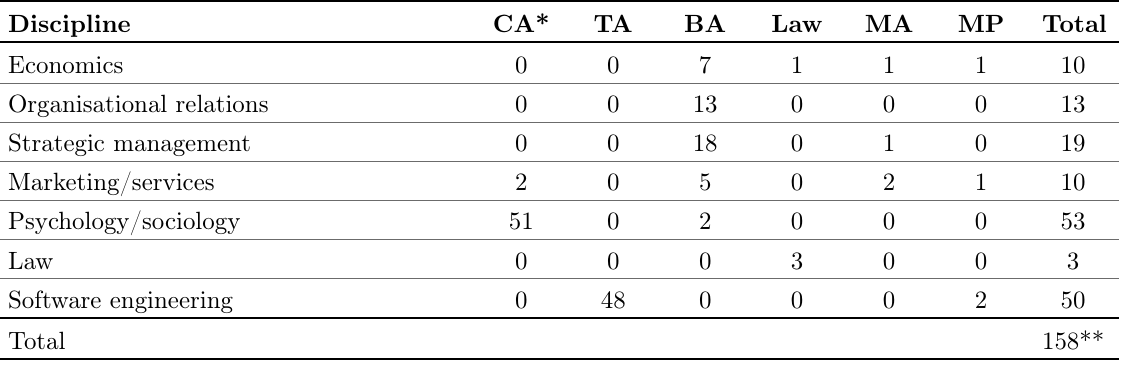
Table 7. Discipline base in mobile payments research. Discipline CA*